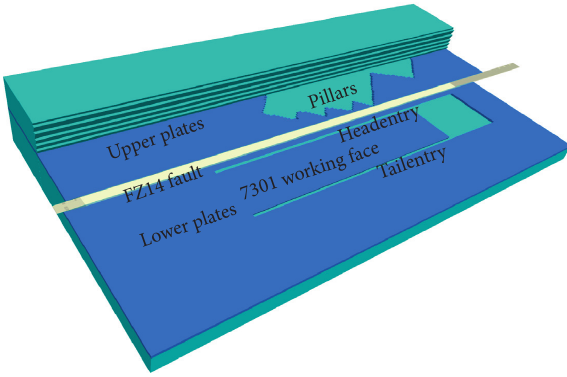
Figure 2: 3D numerical